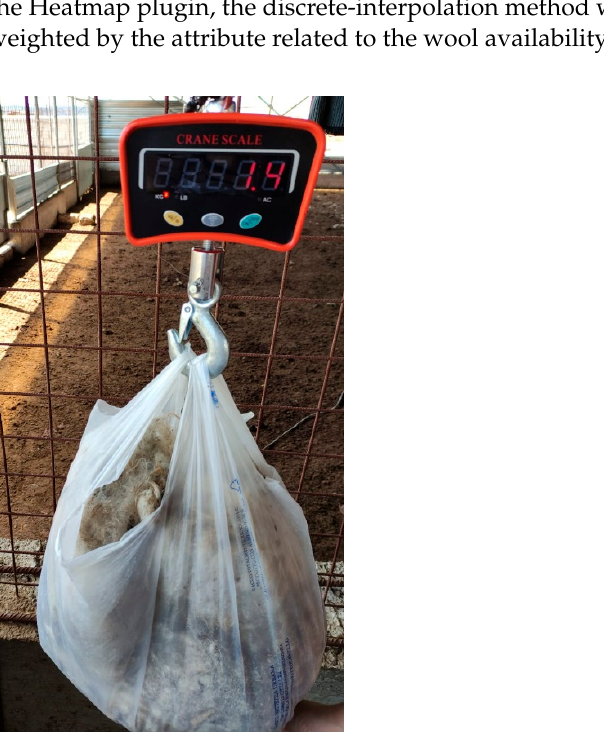
Figure 3. Example of weight activity of sheared wool.